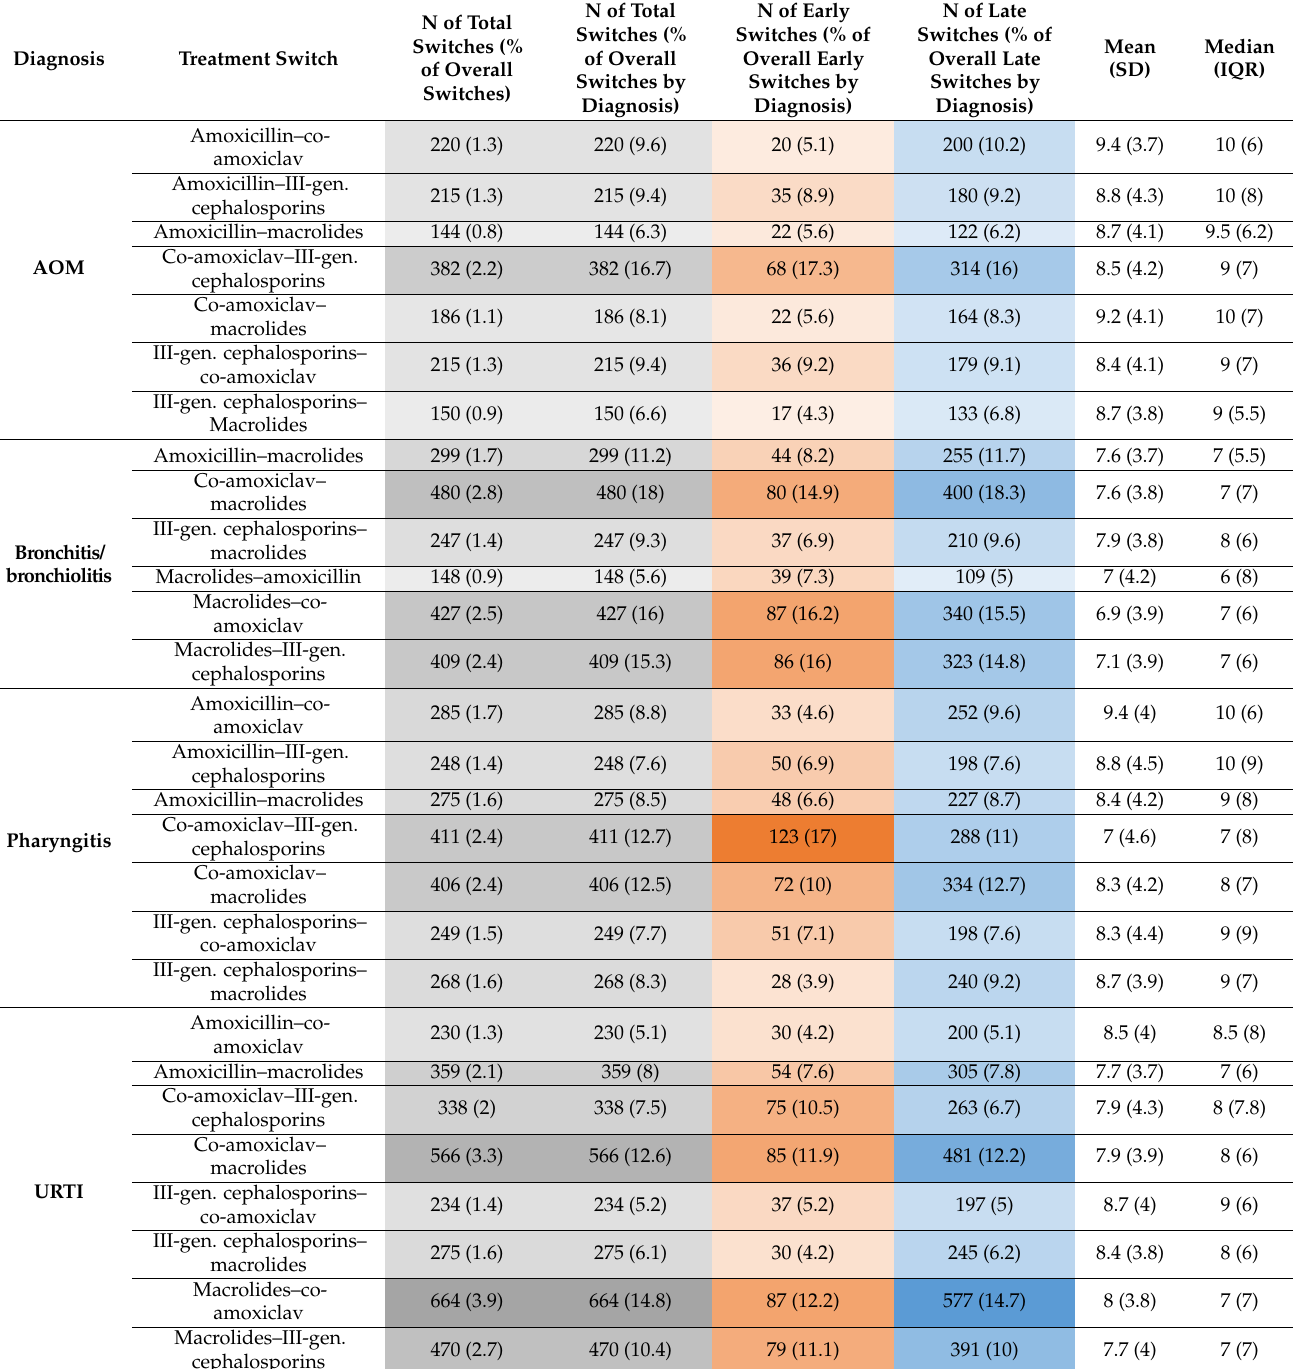
Table 2. Heat map of antibiotic treatment switching rate (overall, early, and late) stratified by diagnosis with the mean and the median day of switching. Only treatment switches with a prevalence rate by diagnosis higher than 5% are reported (Pedianet,